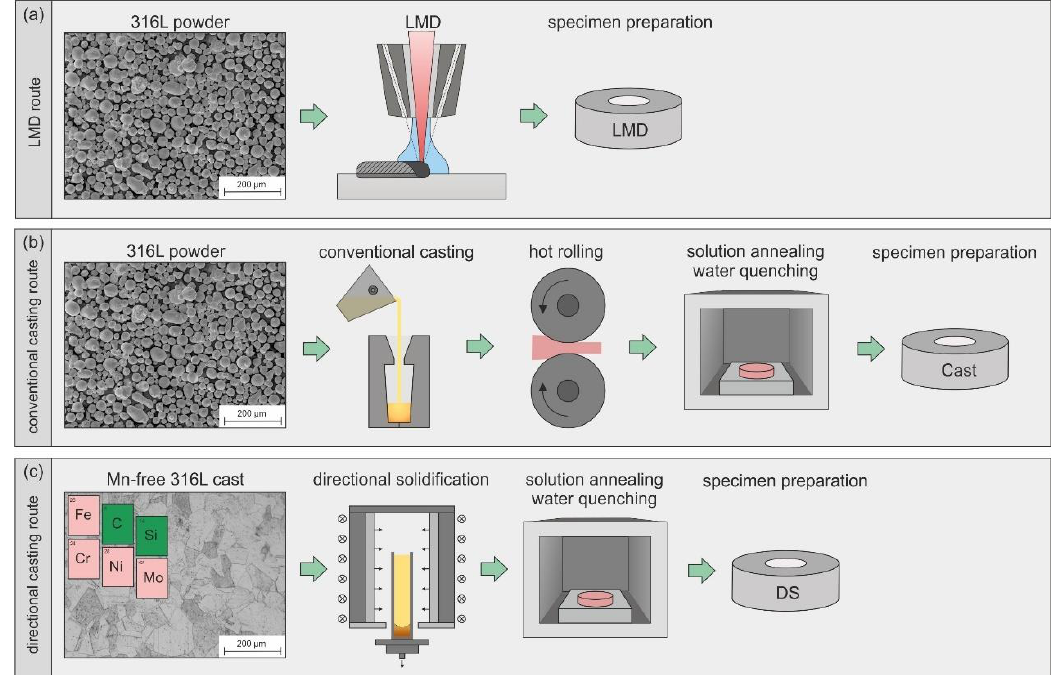
Figure 1. Schematic illustration of the ( a ) laser metal deposition (LMD) processing route, ( b ) Figure1. Schematicillustrationofthe( a )lasermetaldeposition(LMD)processingroute, ( b )conventional conventional casting route, and ( c ) directional casting route. casting route, and ( c ) directional casting